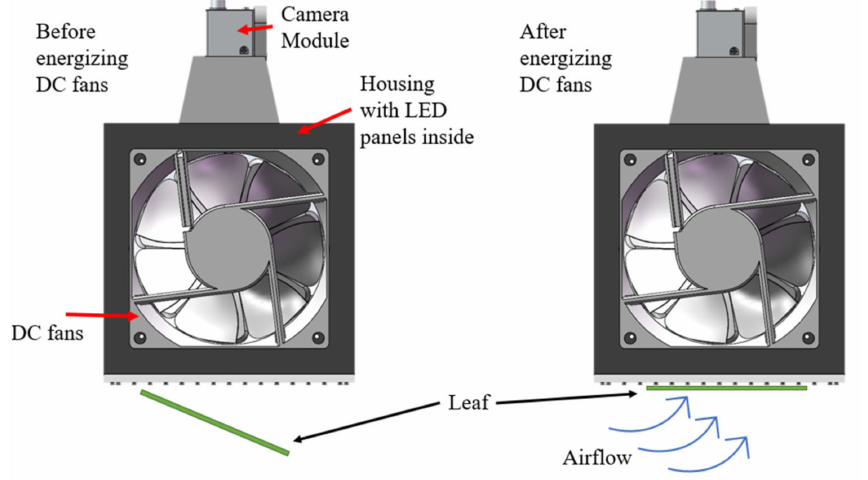
Figure 1. Device